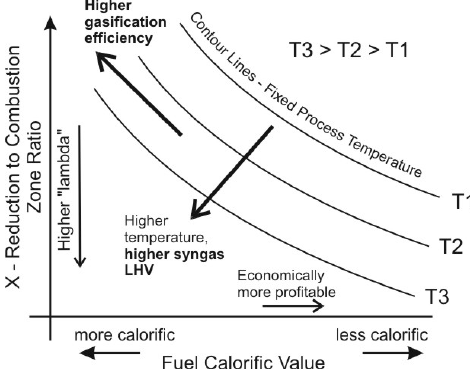
Figure 5. lines for process temperature (T1, T2, T3). Figure 5. Lines for process temperature (T1, T2,